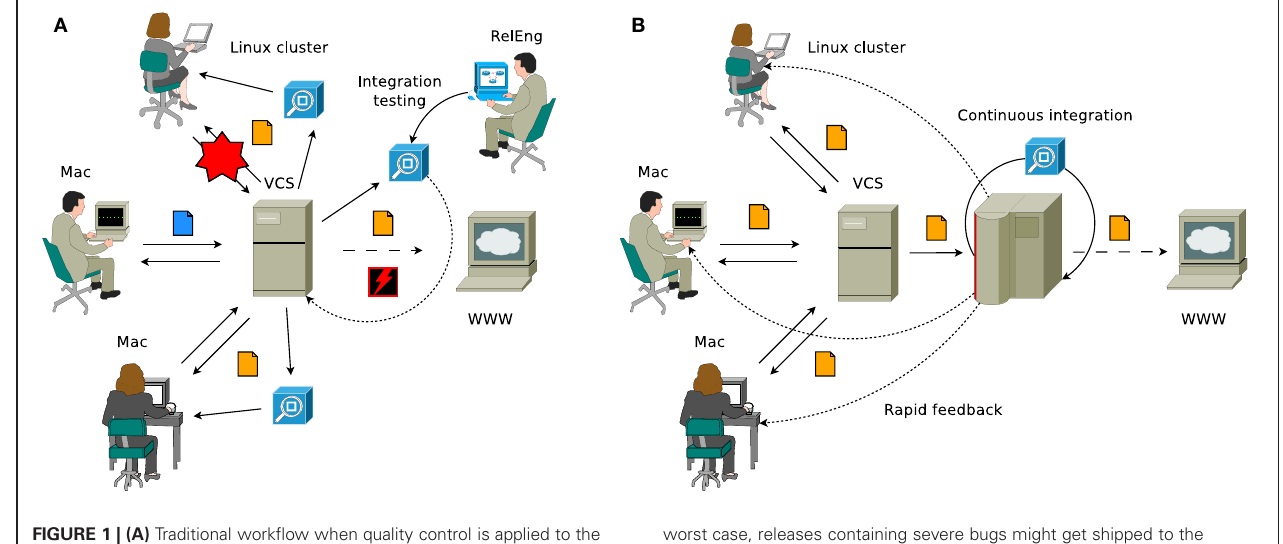
worst case, releases containing severe bugs might get shipped to the external users (represented by the red flash). (B) Agile continuous integration-based workflow, where a central server is set up to monitor the state of the source code, collect code metrics and perform automated testing. The changes are integrated into the main tree directly as they are being developed and releases are produced when all automated testing procedures pass. Regular testing is now being performed automatically by the continuous integration server in a standard setting (so no committed changes will remain untested) and developers are immediately notified in the case if committed changes have caused build breakages or test